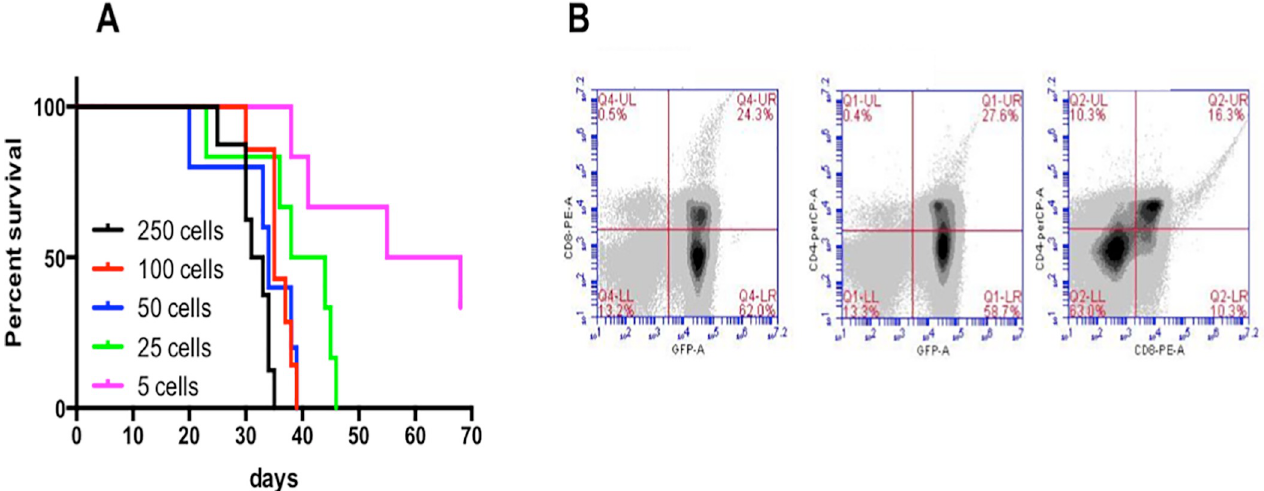
Fig 2. Leukemogenesis was generated by direct injection of splenic ICN-1-induced T-ALL cells. (A) Kaplan-Meier survival curve of p16+/Luc mice receiving 250, 100, 50, 25, and 5 T-ALL cells. 6 mice were for each dose of injections, including 3 females and 3 males. (B) GFP analysis and CD4+CD8+ surface staining of splenocytes. Numbers in each dot plot refer to the percentages in each quadrant. Cells that express GFP from the Notch1-expressing retrovirus represent T-ALL cells.